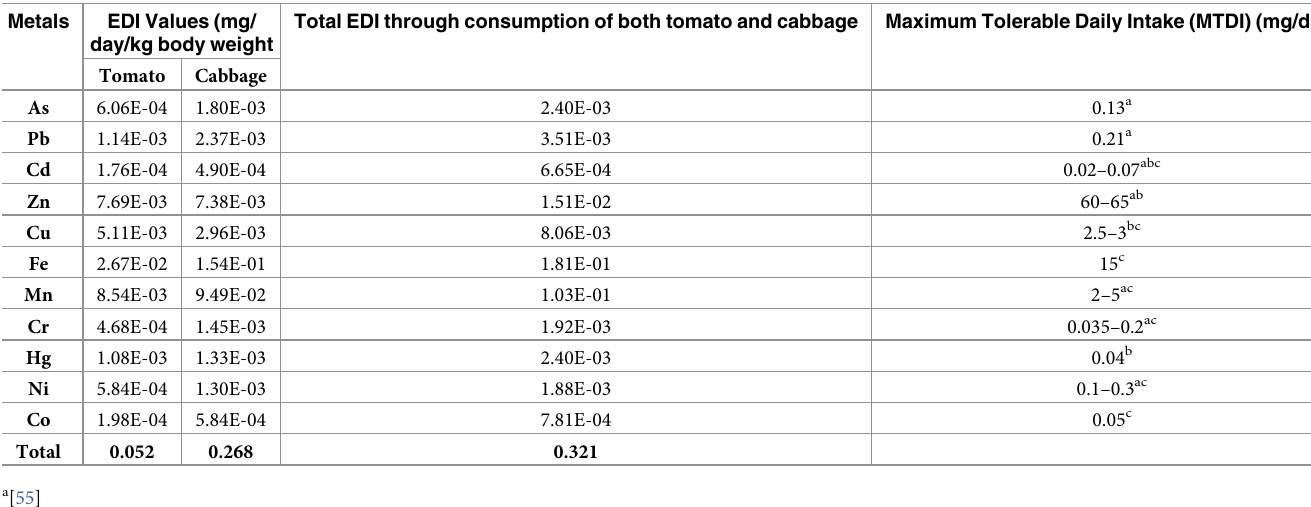
Table 6. Estimated daily intake (mg/day/kg body weight) of toxic metals for adult population due to the consumption of contaminated vegetables in Mojo area, cen- tral Ethiopia. EDI Values (mg/ Total EDI through consumption of both tomato and day/kg body weight